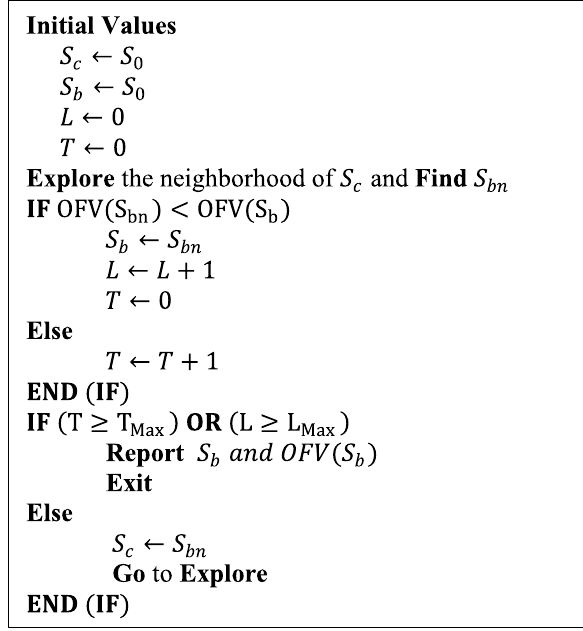
Fig. 5 Pseudocode of the tabu search